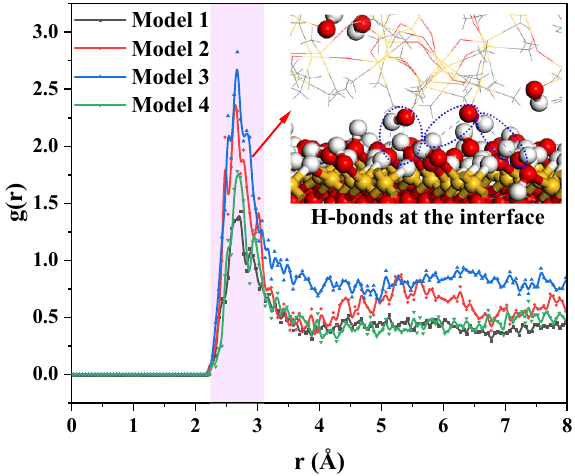
Fig. 8 The RDFs of oxygen atoms (O-O) between the hydroxyl groups of silica and hydroxyl groups of PDMS matrix in the different interface model